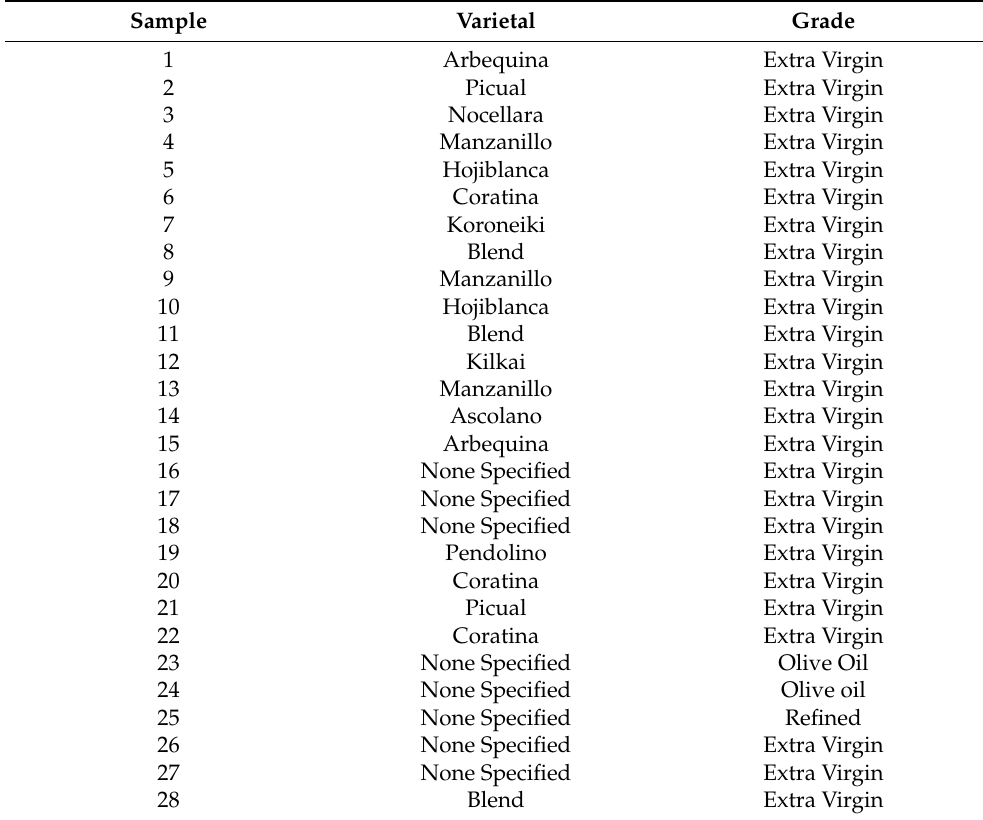
Table 1. List of olive oil samples used.